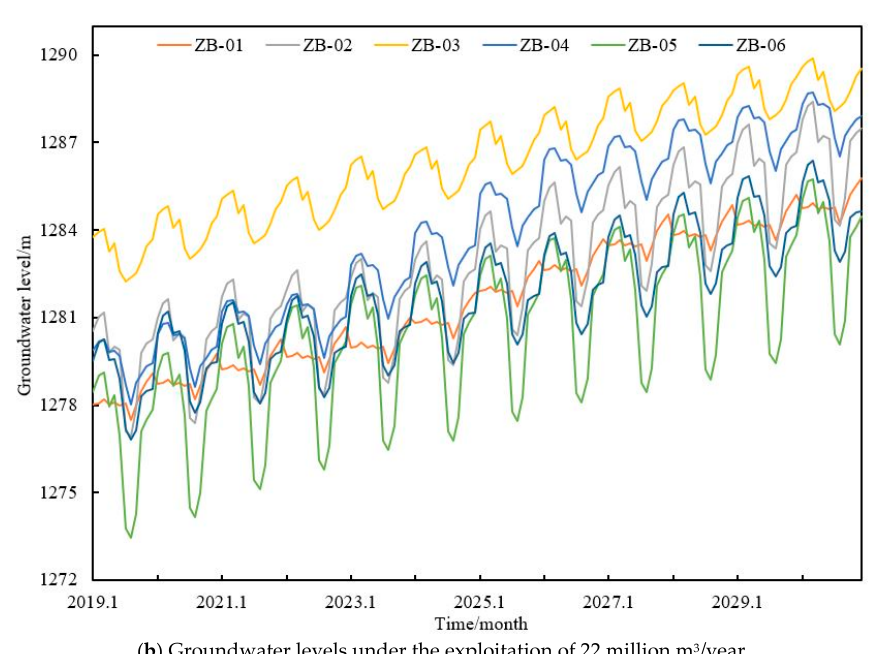
Figure 10. Duration curves of the groundwater levels of six monitoring wells from 2019 to 2030 under different mining scenarios.